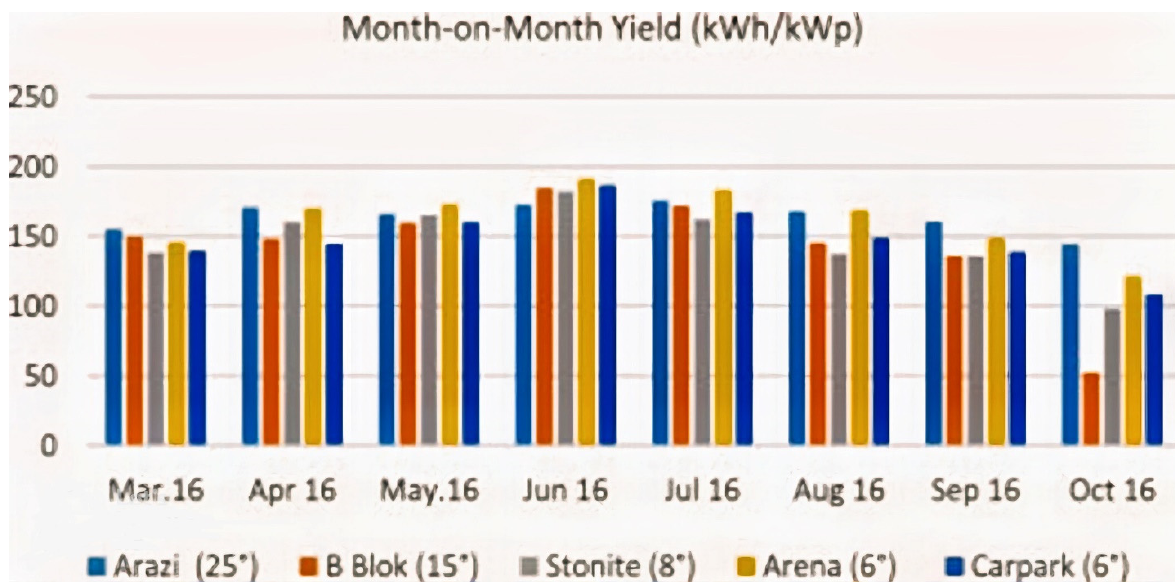
Figure 17. Monthly specific yield for all PV installations during an eight-month period [104].